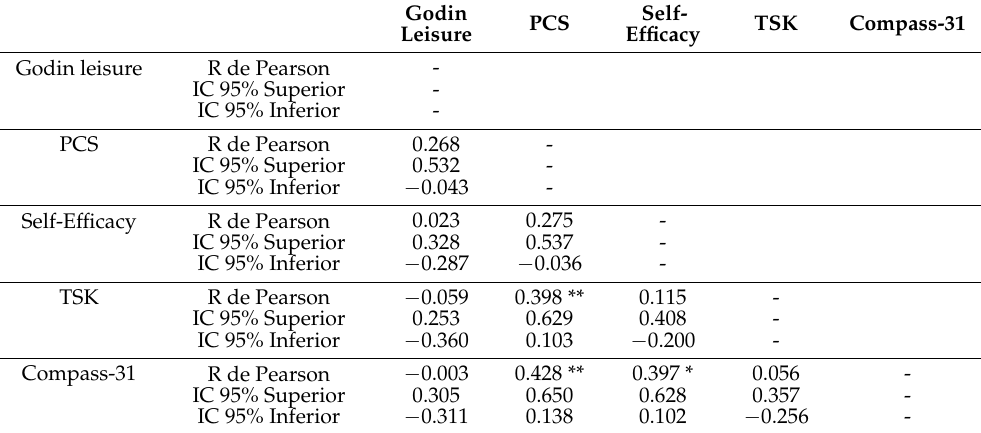
Table 2. Matrix correlation between